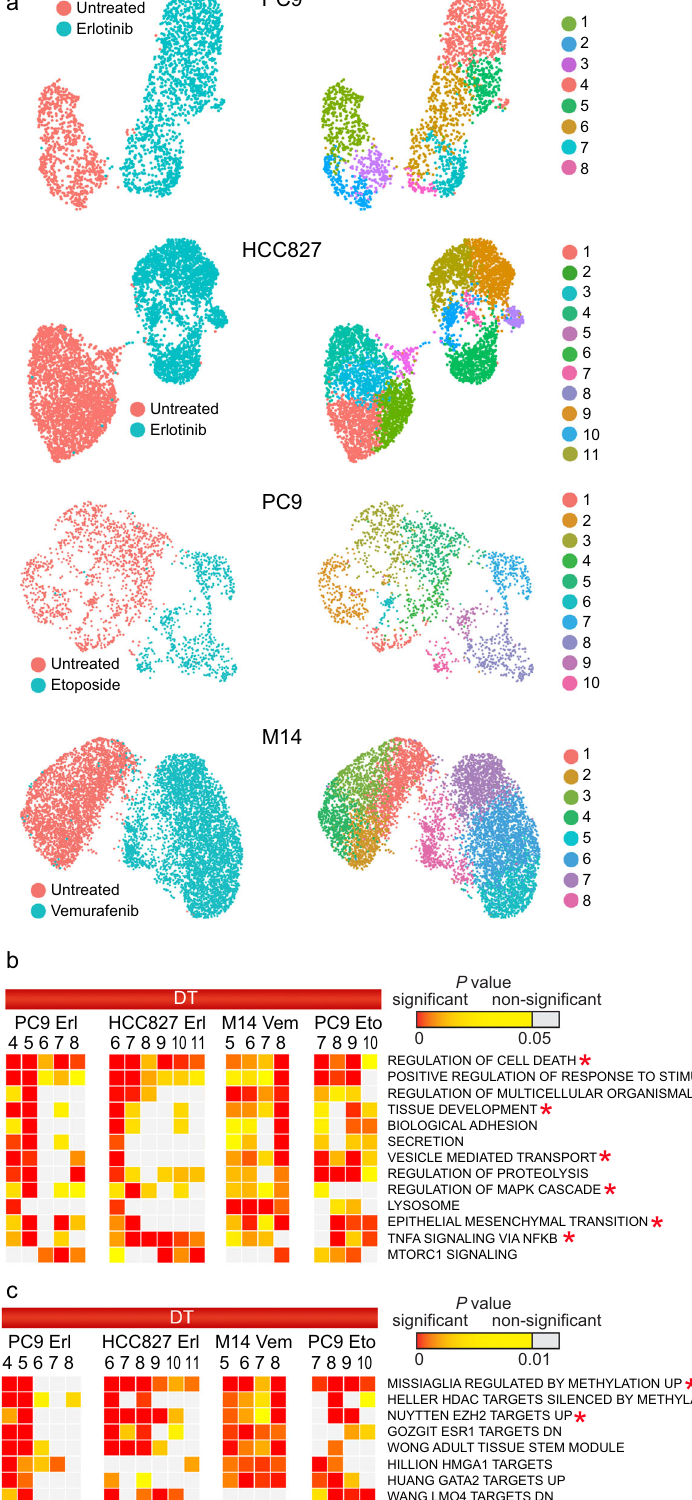
Fig. 3 Common biological processes can be identi fi ed in tolerant subpopulations of distinct cell lines emerging from different treatments. a UMAP representation of cells in four models of drug tolerance. Cells are colored by days of treatment (left panels) and clusters (right panels). b Enrichment analysis for gene relations to GO BPs, KEGG pathways, or hallmark gene sets (MSigDB Collections) is shown for top markers of tolerant clusters ( P < 0.05). Gene sets appearing highly signi fi cant at least in three out of four different treatments and with P > 10 − 4 in any of the clusters of untreated cells are shown. c Enrichment analysis for gene sets associated with chemical and genetic perturbations (CGPs). Gene sets that appear highly signi fi cant at least in three out of four different treatments are shown. In b and c , data represents right tail P values, two-sided binomial statistical test, adjusted for multiple testing using Benjamini – Hochberg FDR method. Terms discussed in the text are indicated by